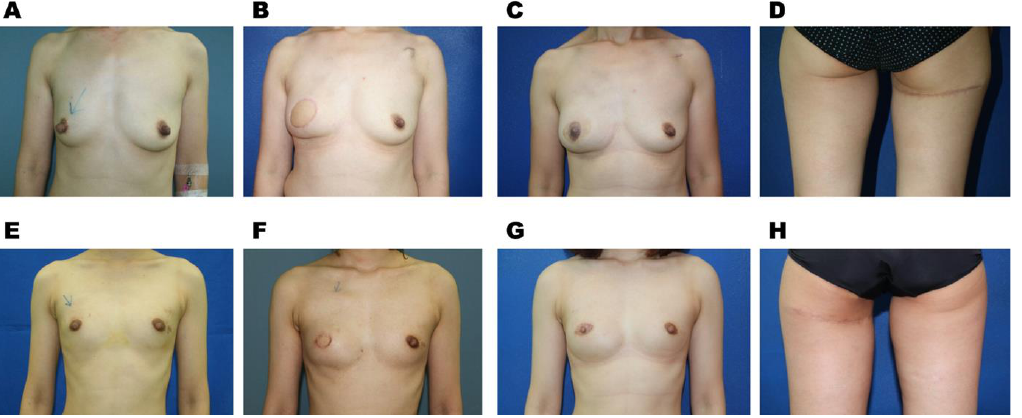
Figure 8. Clinical examples. ( A ) A preoperative anterior posterior view of a 35-year-old female pa- tient with right-breast cancer. Following a skin-sparing mastectomy, reconstruction was performed using a PAP free flap obtained from her right thigh. ( B – D ) Follow-up photos of the 35-year-old female patient. ( B ) Postoperative appearance at her follow-up session of seven months. ( C ) Post- nipple areolar reconstruction at the follow-up session of 21 months from the mastectomy. ( D ) The donor-site appearance 21 months following surgery. ( E ) A preoperative anterior posterior view of a 30-year-old female patient with right-breast cancer. Her postoperative photos are shown in ( F – H ). ( F ) Postoperative anterior posterior view of the patient following a skin-sparing mastectomy and PAP free flap reconstruction at the follow-up session of four months. ( G ) Postoperative photo taken following nipple–areolar reconstruction at the 27-month follow-up session. ( H ) The donor-site scar over her left thigh at the follow-up session of nine